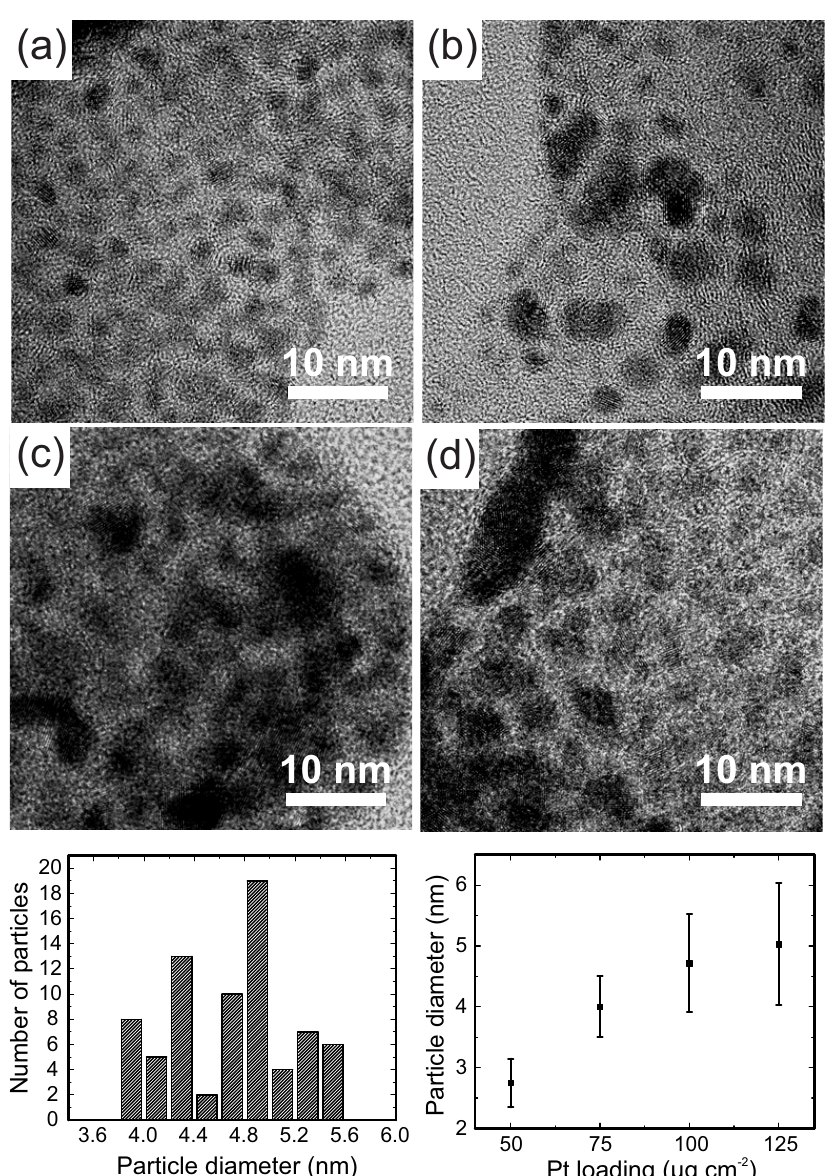
Figure 1. TEM images of Pt particles deposited by PLD at 107-Pa Ar pressure on a GDL with various Pt loadings: ( a ) 50 µ g · cm − 2 ; ( b ) 75 µ g · cm − 2 ; ( c ) 100 µ g · cm − 2 and ( d ) 125 µ g · cm − 2 . The size distribution for 100 µ g · cm − 2 and the dependence of particle diameter on Pt loading are shown in the bottom panels. The error bar for each case indicates the standard deviation of particle size